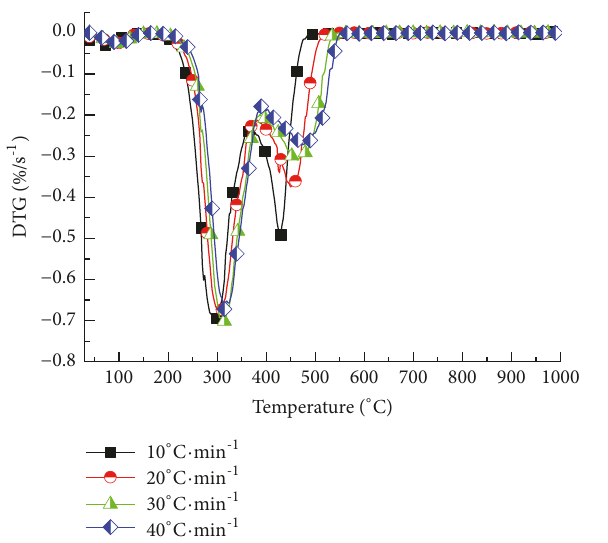
Figure 2: Combustion DTG curves of wood powders.